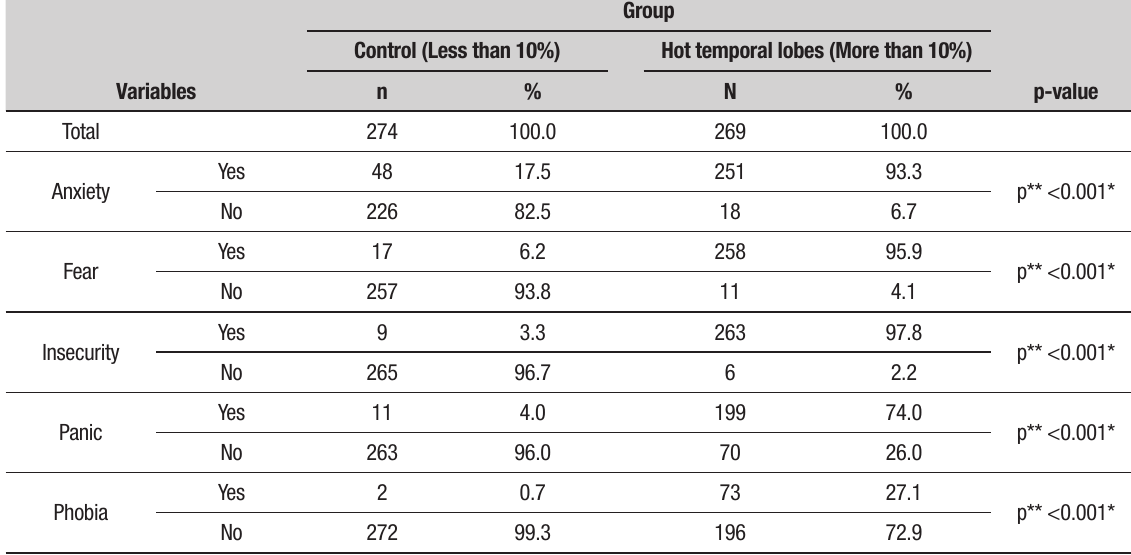
Table 4. Evaluation of symptoms according to group: Percent of High Beta (23-38 Hz) wave in left temporal lobe (T4).